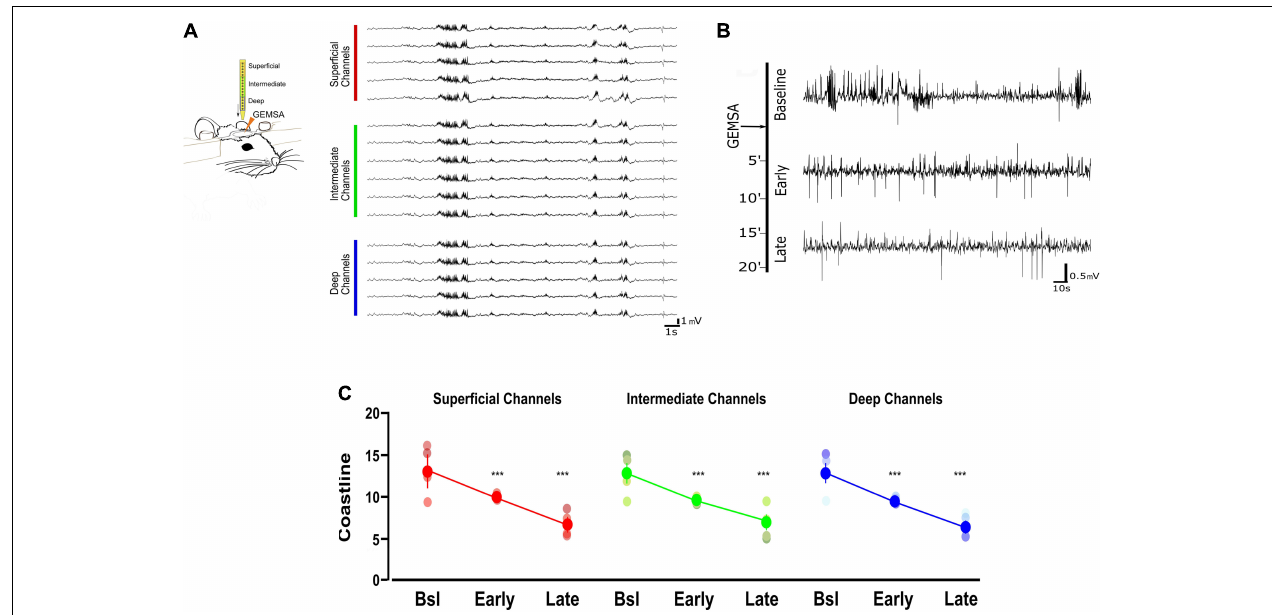
FIGURE 4 | Acute inhibition of Carboxypeptidase (CPE) decreases hyperexcitability in TeNT-injected mice. (A) Left: diagram of experimental design: a 16-channel silicone probe was used to record LFP in different layers of the primary visual cortex, channels were analyzed in three groups according to their recording sites in relation to the surface of the cortex: the five most superficial, the five deepest, and the six intermediate channels. GEMSA was applied locally to inhibit CPE activity. Right: Examples of LFP traces obtained with a 16-channels probe from the visual cortex of an Acute epileptic mouse. (B) LFP traces of an Acute epileptic mouse before (baseline, top) and after GEMSA administration at two different time points: early (5–10 min) and late (10–20 min). (C) Coastline analysis of LFP signals recorded before (baseline) and after GEMSA administration at early and late time points. The analysis was differentially performed for superficial (left, red), intermediate (middle, green), and deep (right, blue) channels (Two-way ANOVA, Channel factor p > 0.05, Time factor p < 0.001; Baseline vs. Early: p < 0.01, Baseline vs. Late: p < 0.001, Early vs. Late: p < 0.001, n = 4). The mean, SEM, and value of individual recordings are shown for each group. *** p <